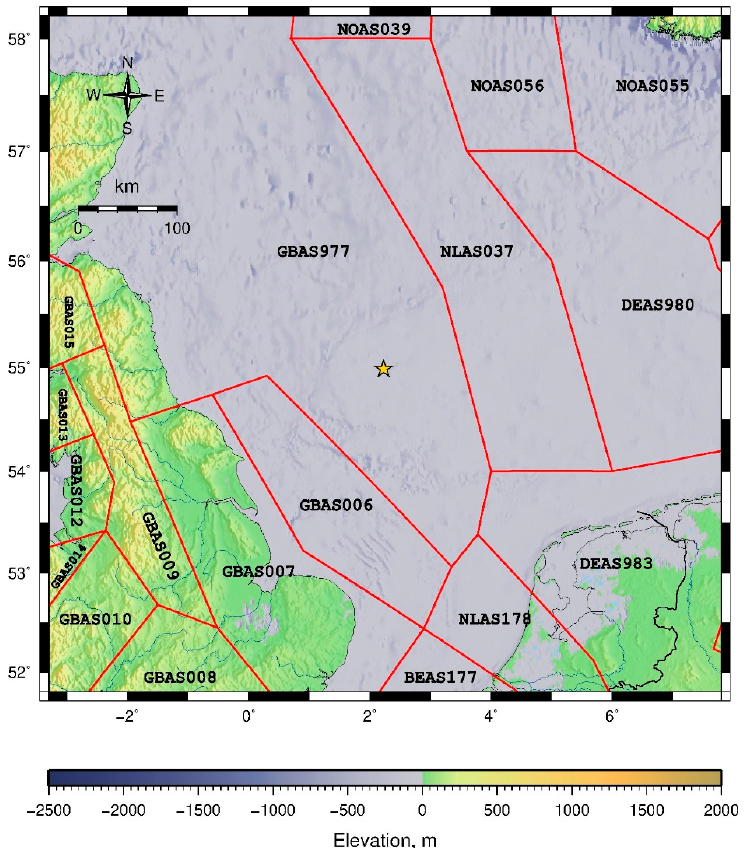
Figure 2. Location of areal source zones for SSM2 based on the SHARE project [16]. The yellow star indicates the center of the wind farm zone.